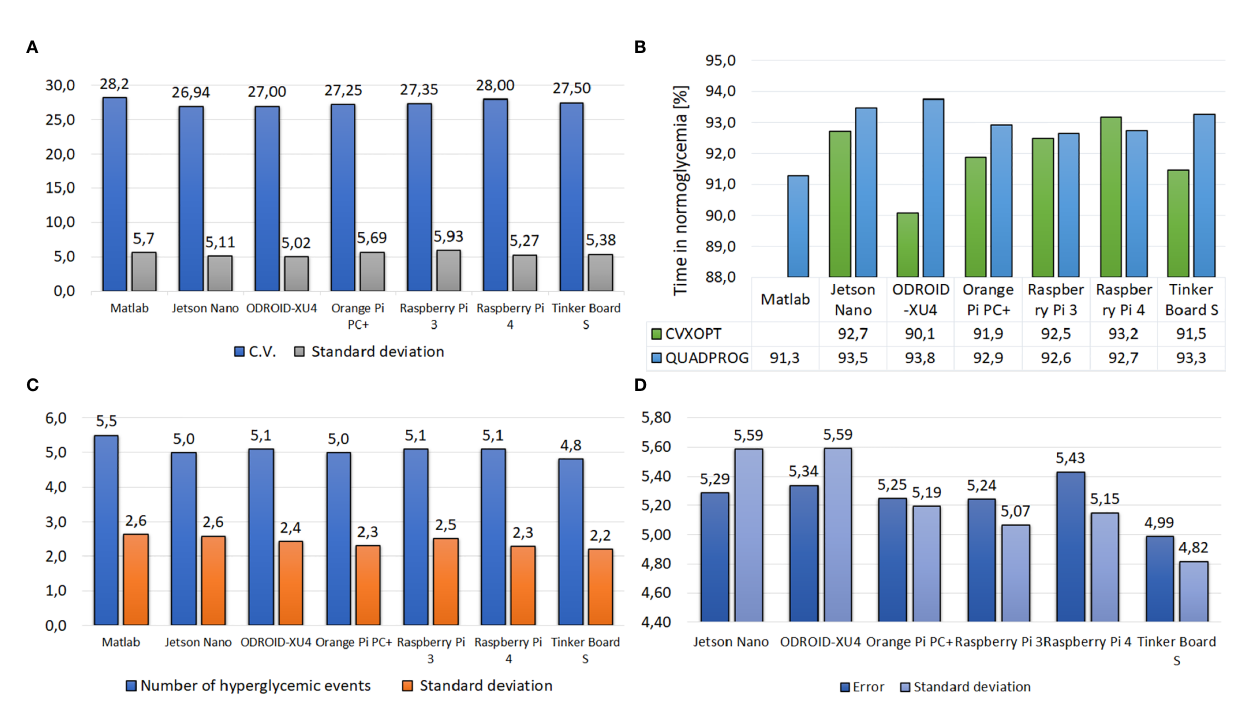
FIGURE 9 | Results of each embedded system under the ZMPC-AV-OF strategy, (A) Coef fi cient of Variation, (B) Time percentage in normoglycemia, (C) Number of cases above 180 mg/dl, and (D) Error with respect to